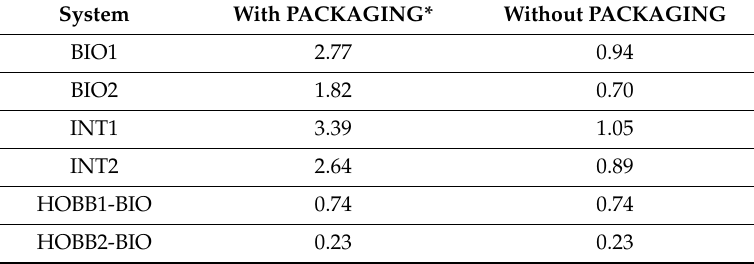
Table 9. Global warming (kg CO 2 eq l –1 ) for each analyzed system with and without